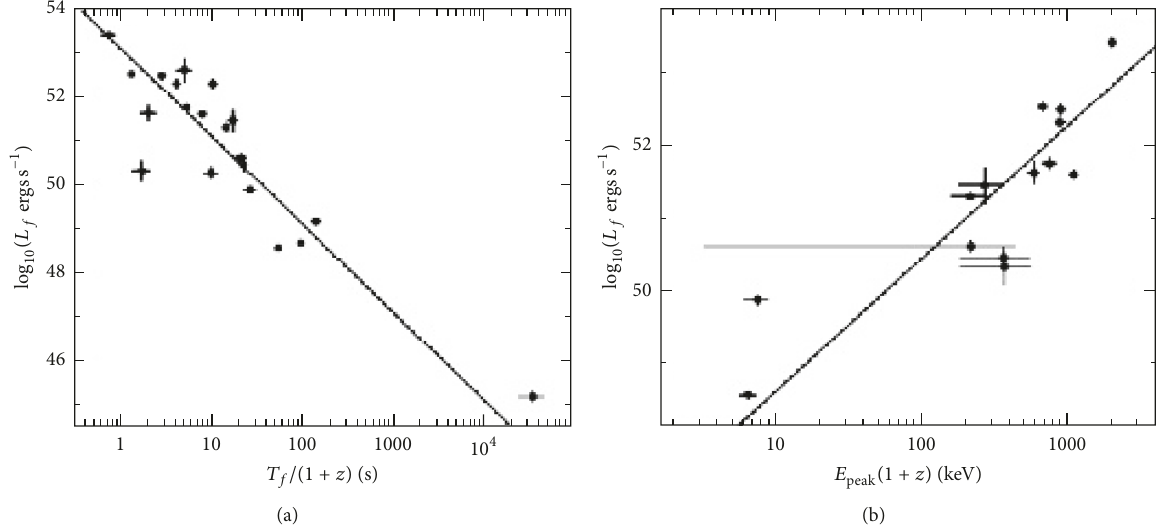
Figure 15: (a) 𝐿 𝑓 (in ergs −1 ) versus 𝑇 ∗ 𝑓 . (b) 𝐿 𝑓 (in erg s −1 ) versus 𝐸